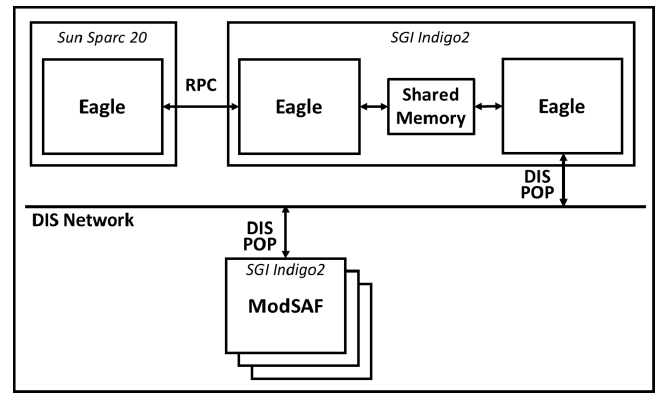
Figure 9. CLCGF simulation engine components and interfaces (adapted from [38,39]).